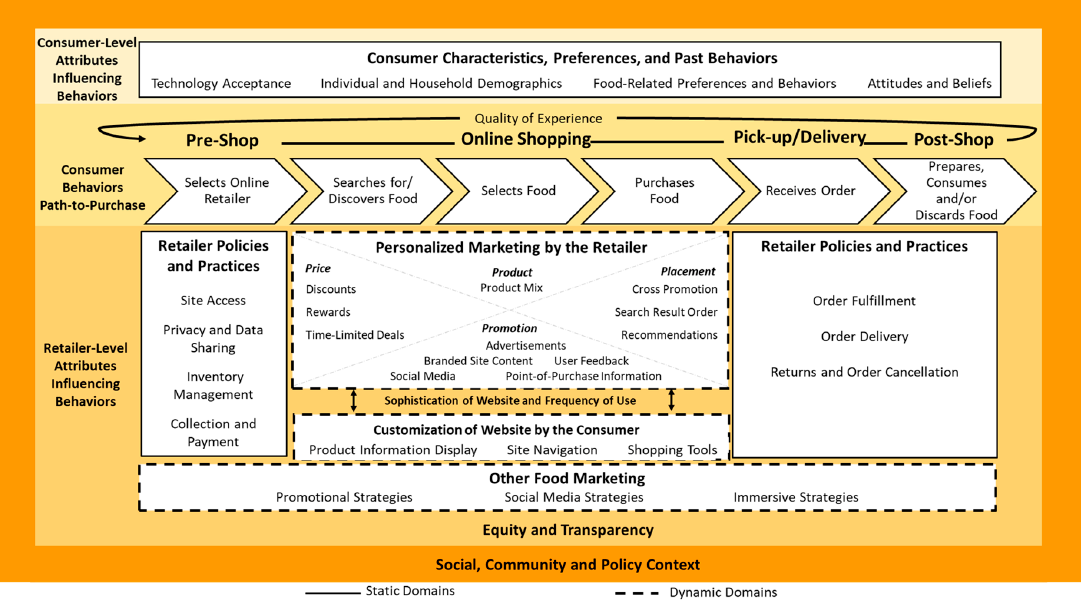
Figure 1. Consumer behavior in the online food retail environment .